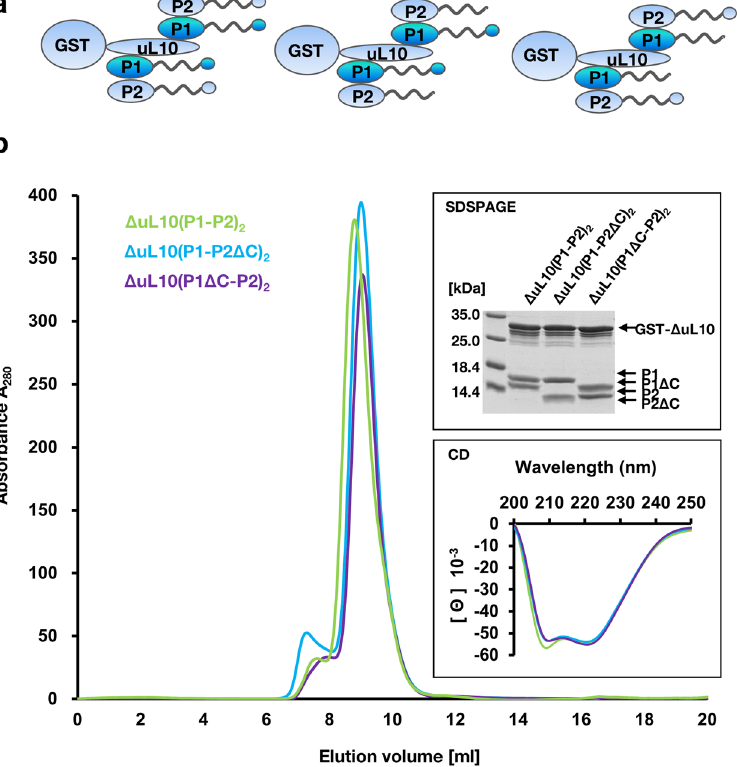
Figure 3. Characterization of human ribosomal stalk pentamer Δ uL10(P1-P2) 2 complexes. (a) Models of human ribosomal stalk pentamer complexes deleted in conserved C-terminal sequences (16aa) of P1 or P2. (b) Size exclusion chromatography (SEC) of recombinant stalk pentamer Δ uL10(P1-P2) 2 complexes. Purified complexes (10 μ g of protein) were subjected to SDSPAGE (upper panel) and circular dichroism (CD) (lower panel). The full-length image of the cropped SDSPAGE gel is shown in Fig. S7.